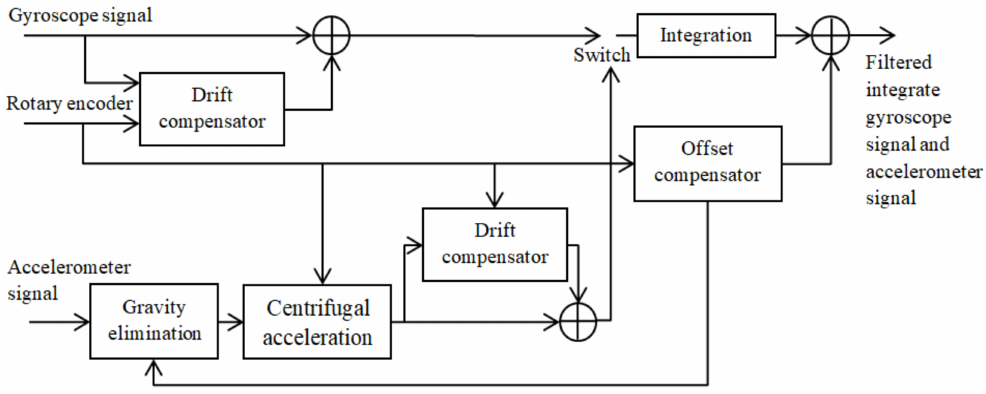
Figure 11. Structure of the enhanced